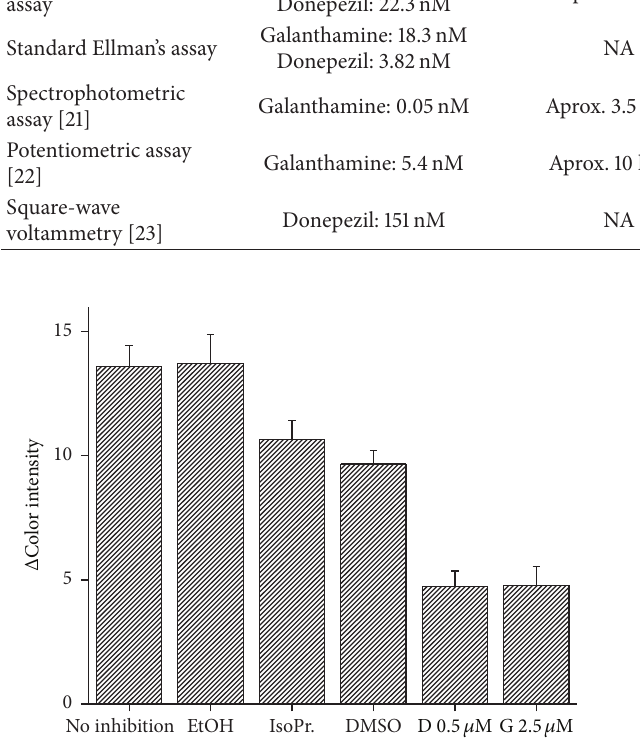
Figure 12: Method interferences by organic solvents. EtOH = ethanol, IsoPr. = isopropyl alcohol, DMSO = dimethyl sulfoxide, D 0.5 𝜇 M = donepezil in 0.5 𝜇 M concentration, and G 2.5 𝜇 M = galanthamine in 2.5 𝜇 M concentration. Error bars represent standard error of the mean for 𝑛 =